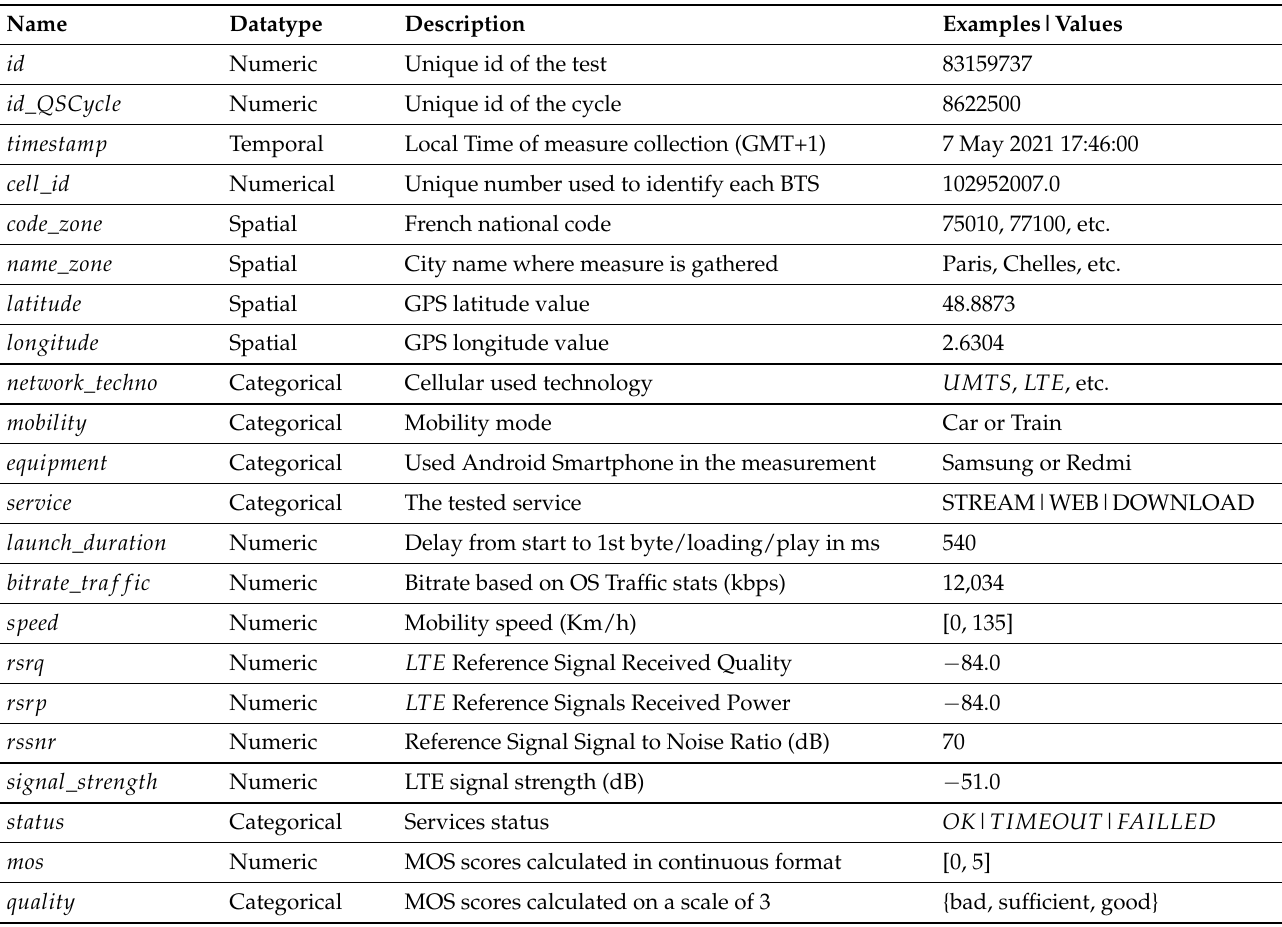
Table 1. Description of the dataset variables.